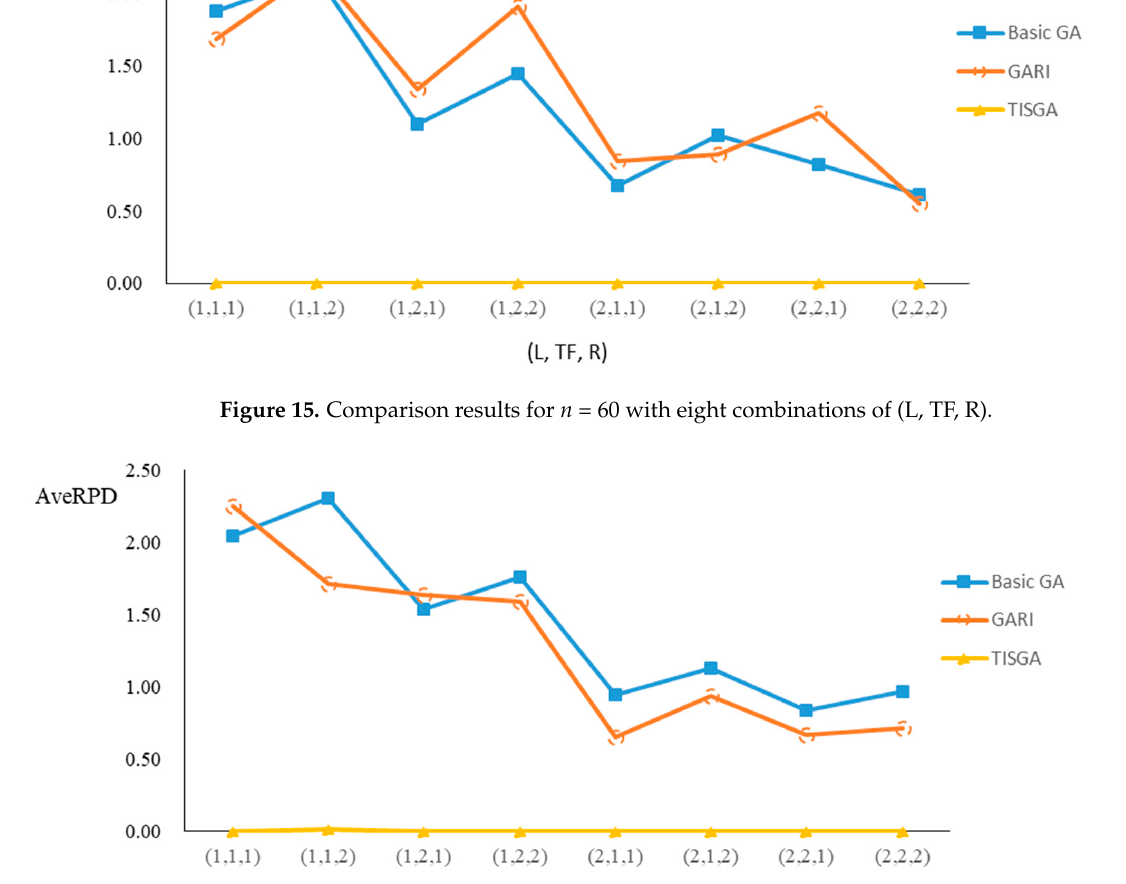
Figure 16. Comparison results for n = 70 with eight combinations of (L, TF, R).